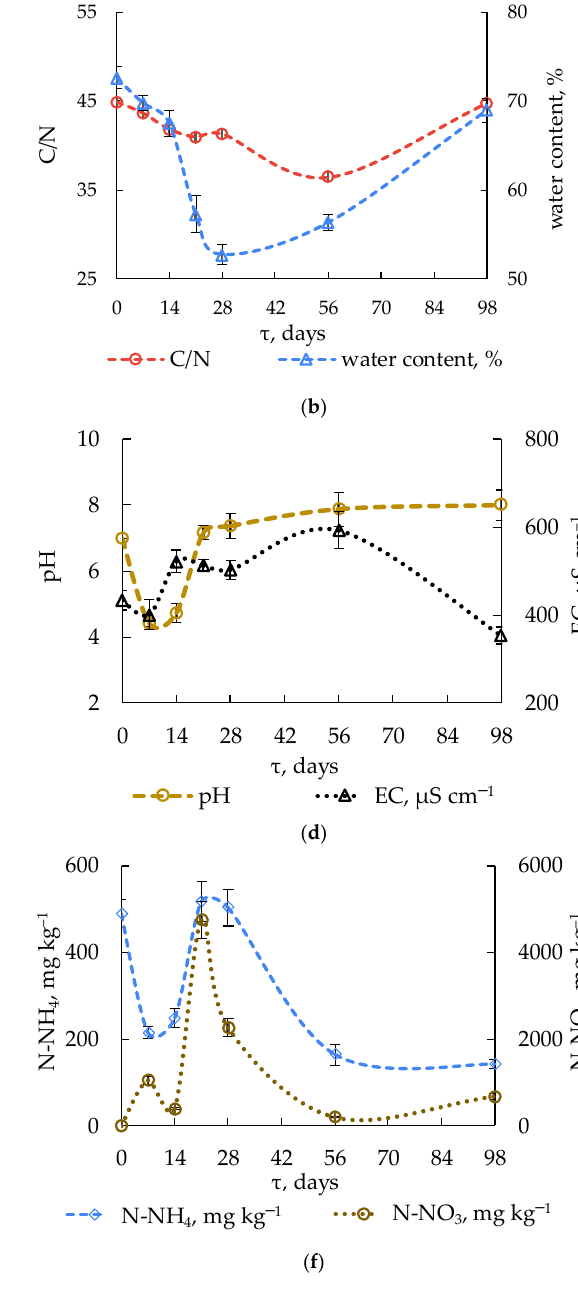
Figure 2. Dynamics of physicochemical parameters during composting: ( a ) the temperature regime: T, substrate temperature; Tout, ambient temperature; 1–5—stirring for 2 min; 4 and 5—addition of water; ( b ) mass water content and C/N ratio; ( c ) CO 2 production; ( d ) pH and the electrical conductivity (EC); ( e ) ammonia release; ( f ) ammonium and nitrate nitrogen.